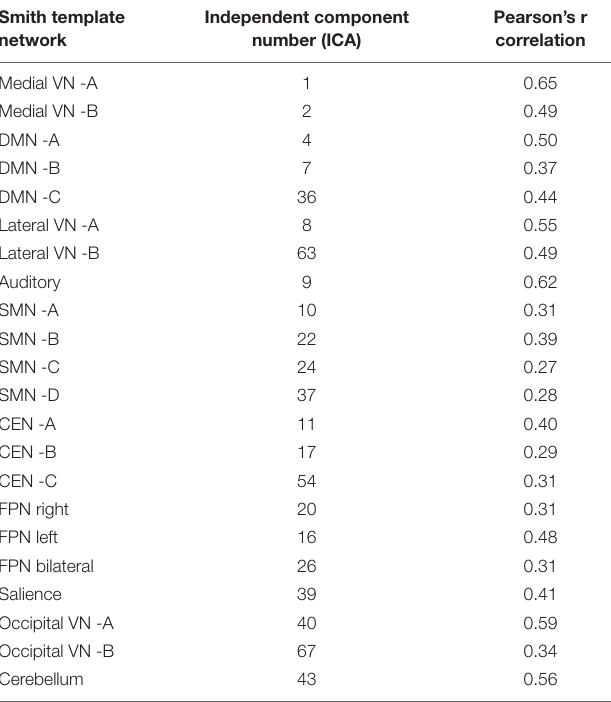
TABLE 3 | Components comprising resting-state network in relation to previously described resting-state network in Smith et al. (2009). Smith template